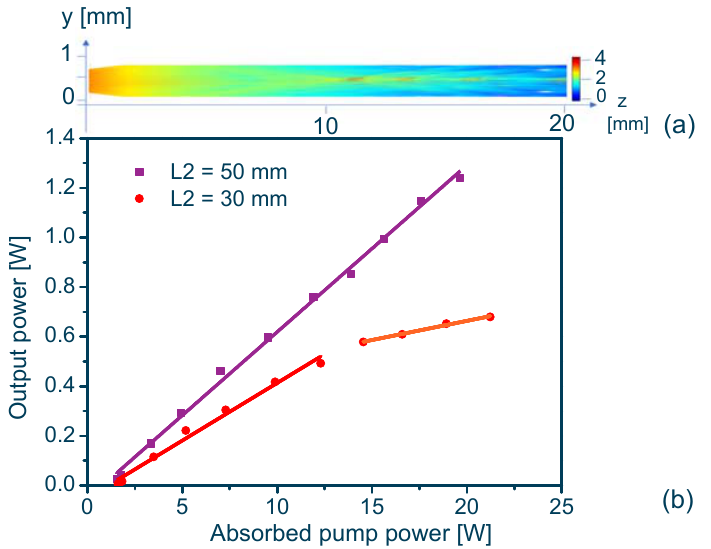
Figure 2. Simulated pump intensity distribution in the SCF with L2 ( f = 30 mm) by using ray tracing analysis ( a ), and output power of Tm:LuAG SCF in different pump configurations ( b ).